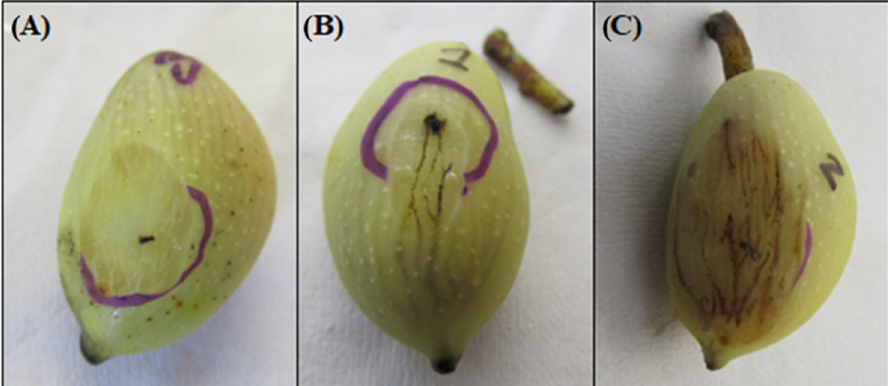
Figure 2. Inoculated pistachio fruits after incubation at 28 ◦ C for one week: ( A ) healthy control fruit inoculated with sterile water; ( B ) necrotic symptoms one week after inoculation with the bacterial isolate OF148; ( C ) necrotic symptoms after incubation for one week with isolate